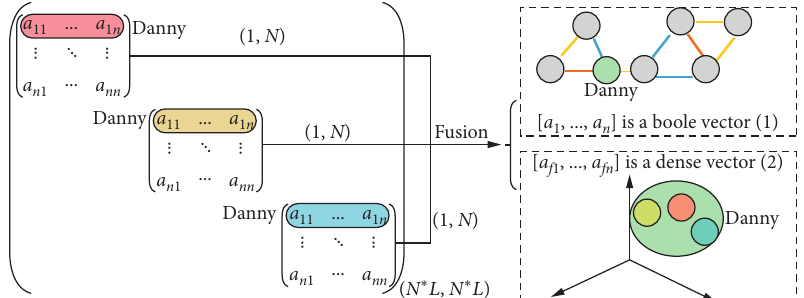
Figure 5: Superadjacency matrix, network feature-level fusion, and network structural-level fusion illustration. Boole vector denotes the result of structural-level fusion and dense vector denotes the result of feature-level